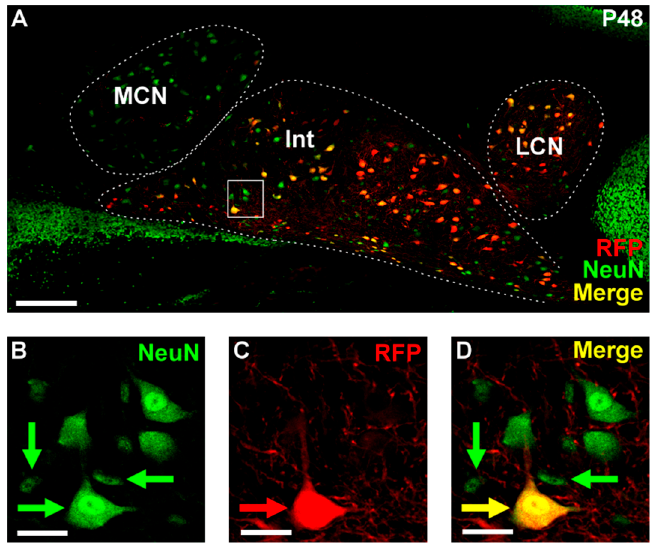
CN = cerebellar nuclei, Int = interposed nucleus, LCN = lateral cerebellar nucleus, MCN = medial cerebellar nucleus.